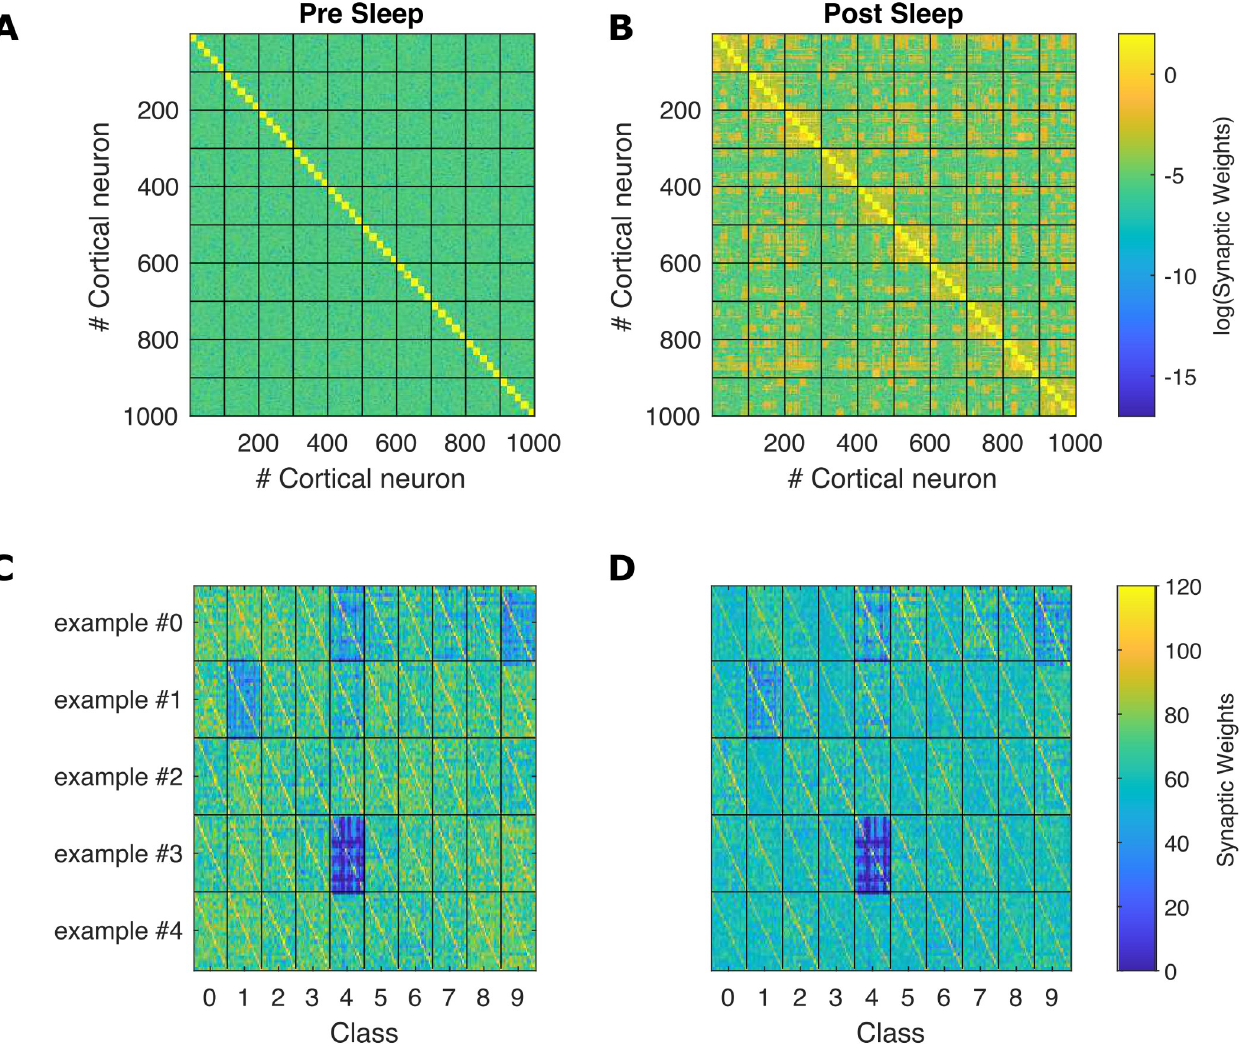
Fig 6. Effects of sleep on intra-class and example-specific synapses after training with a noisy contextual signal. Comparison of synaptic-weight matrices, pre-sleep (Left) vs post-sleep (Right) . Training over 5 examples per class (20 neurons per example). A) and B) depict all cortico-cortical synaptic weights connecting the full set of trained neurons (colour bar, logarithm scale), black lines separate neurons solicited by contextual signal together with thalamic sensorial signal pointing to images belonging to the same digit class in the training phase; C) and D) focus on the synaptic weights connecting groups of cortical neurons simultaneously solicited by a contextual signal in the training phase (thus stimulated over the same sensorial signal identifying images belonging to the same class) (colour bar, linear scale), vertical black lines separate neurons trained over different categories, horizontal black lines separate cortical groups of neurons solicited during the presentation of the same 10 examples (one per digit class). The post-sleep intra-class cooperation is evident in B and in agreement with Fig 5B.b, while the homeostatic effect over example-specific synapses is manifest in D as already suggested by Fig 5B.a. The strong, example-specific differences in synaptic weights (e.g. third example of class 4) are due to the noisy training protocol that introduces randomness in the magnitude of the contextual signal that reaches the example-specific group.